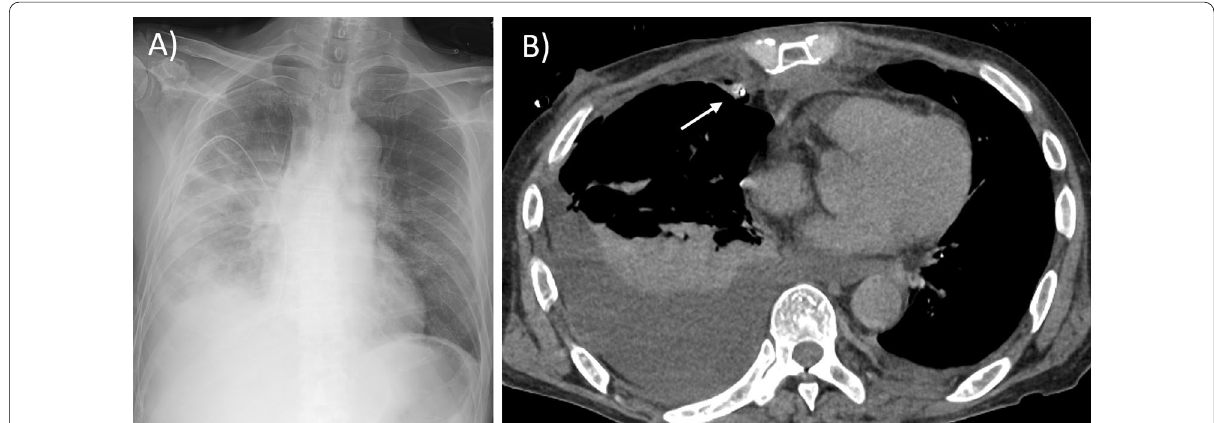
Fig. 2 The right pleural effusion developed after mediastinal drainage. While a drain is inserted into the anterior mediastinum and the mediastinal abscess is reduced, a right massive pleural effusion occurred on the second day of admission ( A , B ). A white arrow shows the drainage tube ( B )